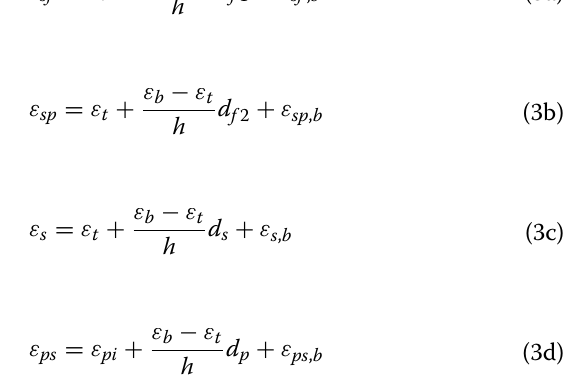
Fig. 9 Measured strain distributions at CIP concrete